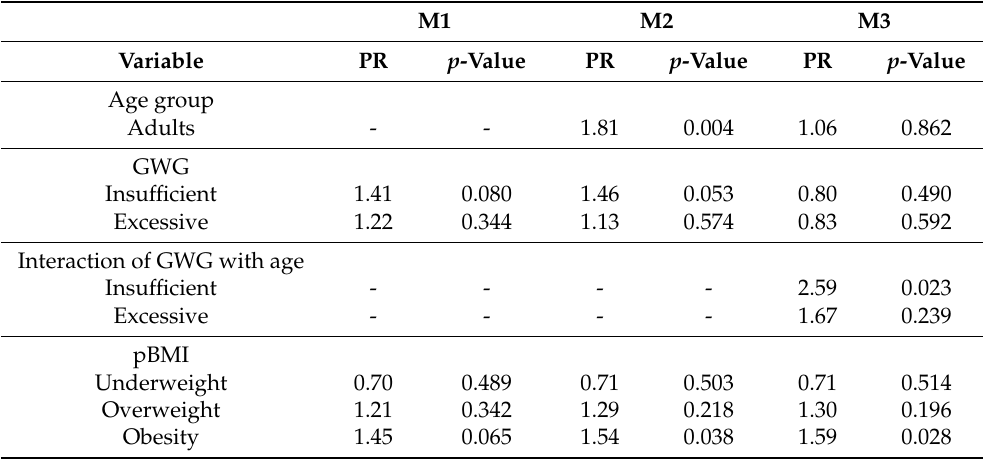
Figure 1. Gestational weight gain by pregestational body mass index. Table 2. Poisson regression models for the association of GWG and pBMI with gestational diabetes as the outcome variable.